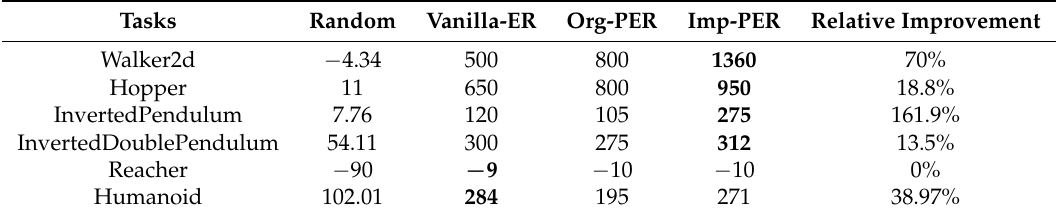
Table 8. Final score and normalized score comparison of all methods on MuJoCo. The best scores are shown in bold font. The Random represents a random policy. The relative improvement represents the improved score compare to Org-PER. Bold font shows the best